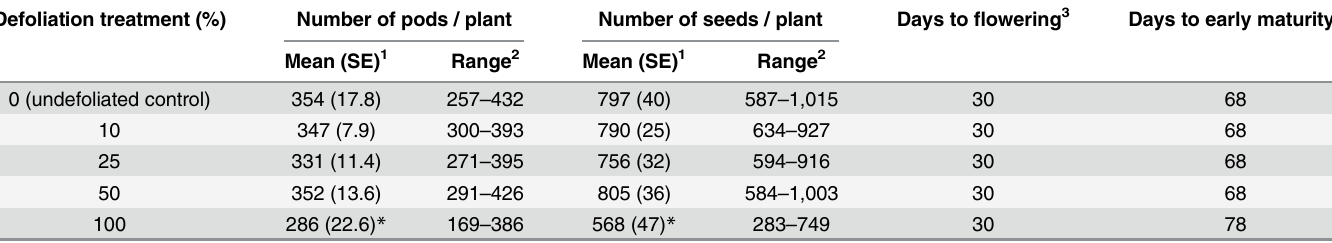
* Indicates a signi fi cant difference between each defoliation treatment relative to the undefoliated control (p < 0.05). 1 SE = standard error 2 Minimum and maximum values observed within each defoliation treatment.